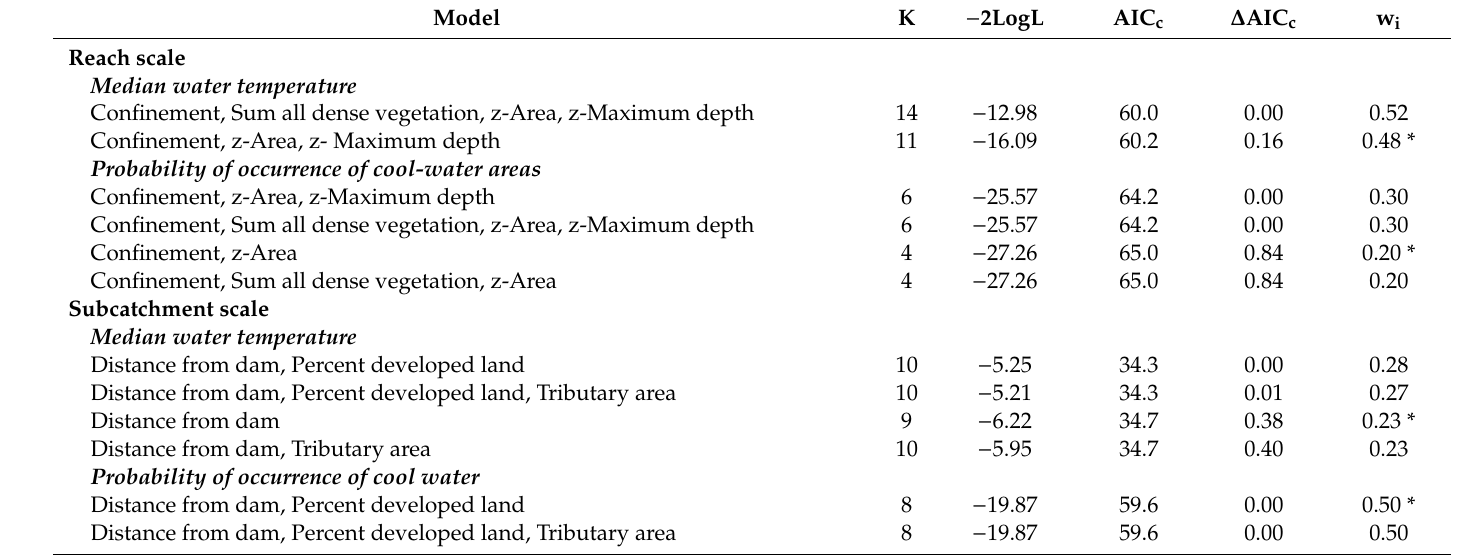
Table 5. Candidate models with reach and subcatchment scale explanatory variables predicting the median radiant water temperature and the probability of occurrence of cool water in the Pend Oreille River. For each model, the number of parameters (K), − 2 log-likelihood ( − 2logL), Akaike’s information criterion adjusted for small sample size (AIC c ), the di ff erence in AIC c between the given model and the best-performing model ( ∆ AIC c ), and Akaike weight (w i ) are shown. An asterisk (*) indicates a model selected based on parsimony in addition to AIC c scores and